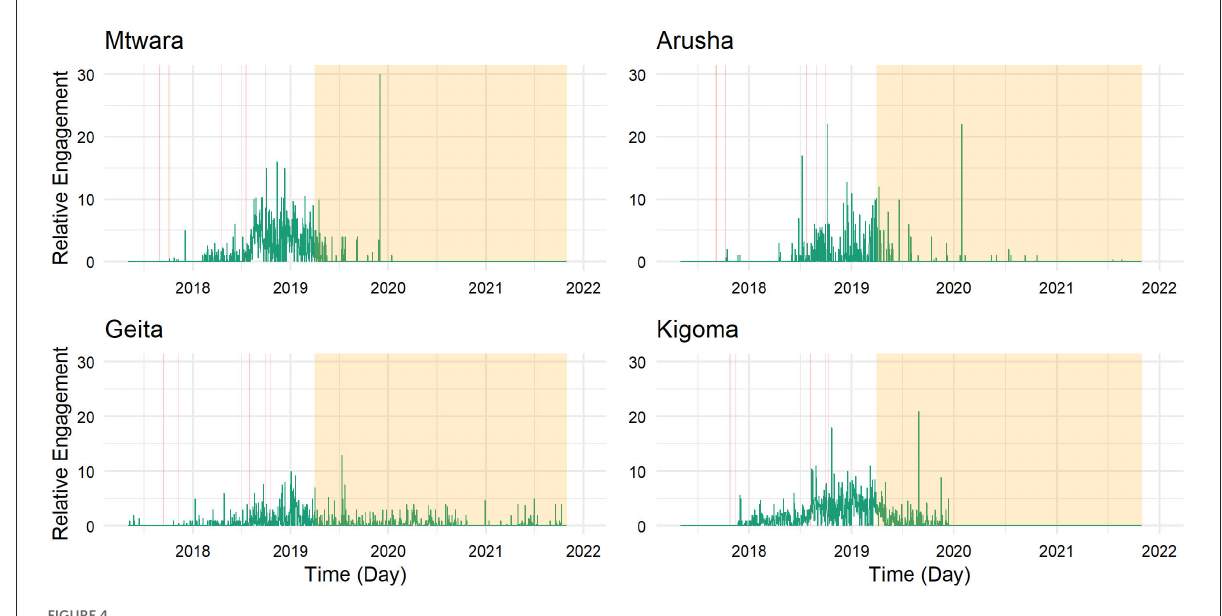
FIGURE4 Twitter engagement received by animators across time per